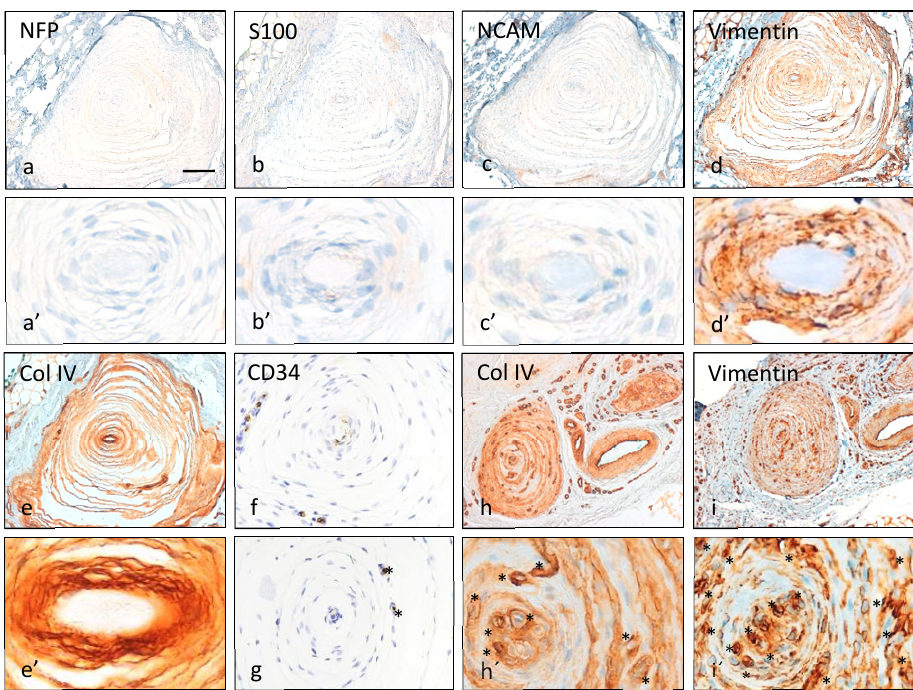
Figure 2. Immunohistochemical findings in consecutive sections of two different Pacinian corpuscles ( a – f , h , i ). The first corpuscle depicted ( a – f ) had no evidence of axonal profile innervating it due to an absent NFP expression (( a ), detailed in ( a’ )); it had neither evidence of inner core, as long as there is no S100 (( b ), detailed in ( b’ )) positivity and N-CAM was also negative (( c ), detailed in ( c’ )); vimentin (( d ), detailed in ( d’ )) left a central zone without expression in the region where the inner core should be. The outer core was well defined by type IV collagen (( e ), detailed in ( e’ )). CD34 from different corpuscles was faintly present ( f ) or absent ( g ) surrounding the inner core region. The second corpuscle depicted in the bottom right ( h , i ) displayed a lamellar architecture of highlighted with Type IV collagen and vimentin expression; and a noticeable vascular proliferation (blood vessels highlighted with *) in the innermost and the capsular regions of the corpuscle was apparent in detail ( h’ , i’ ). Scale bar corresponds to 100 μ m images ( a – e , h – i ), to 60 μ m in images ( f , g ), 30 μ m in the detailed images ( h’ , i’ ), and 15 μ m in ( a ’– e’ ).